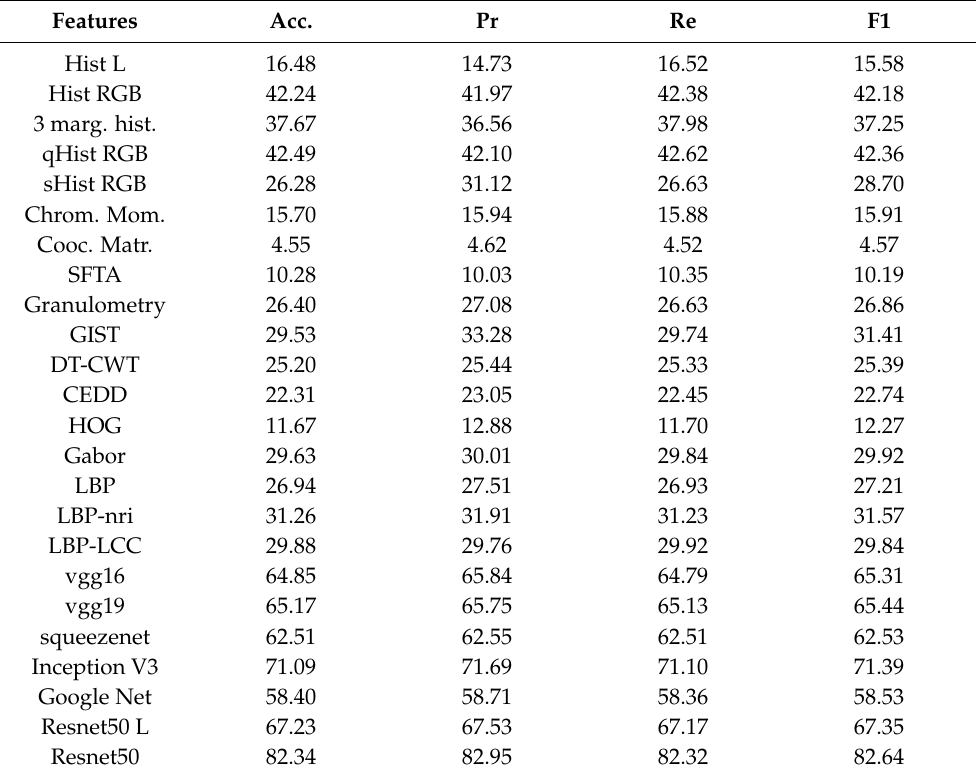
Table 2. Benchmark using 1-Nearest-Neighbor (1-NN) (1129 classes).